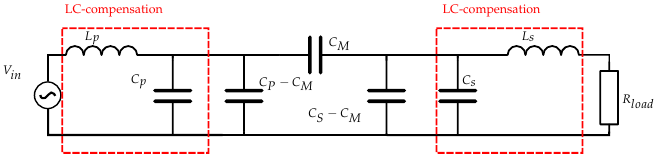
Figure 14. Double side compensation